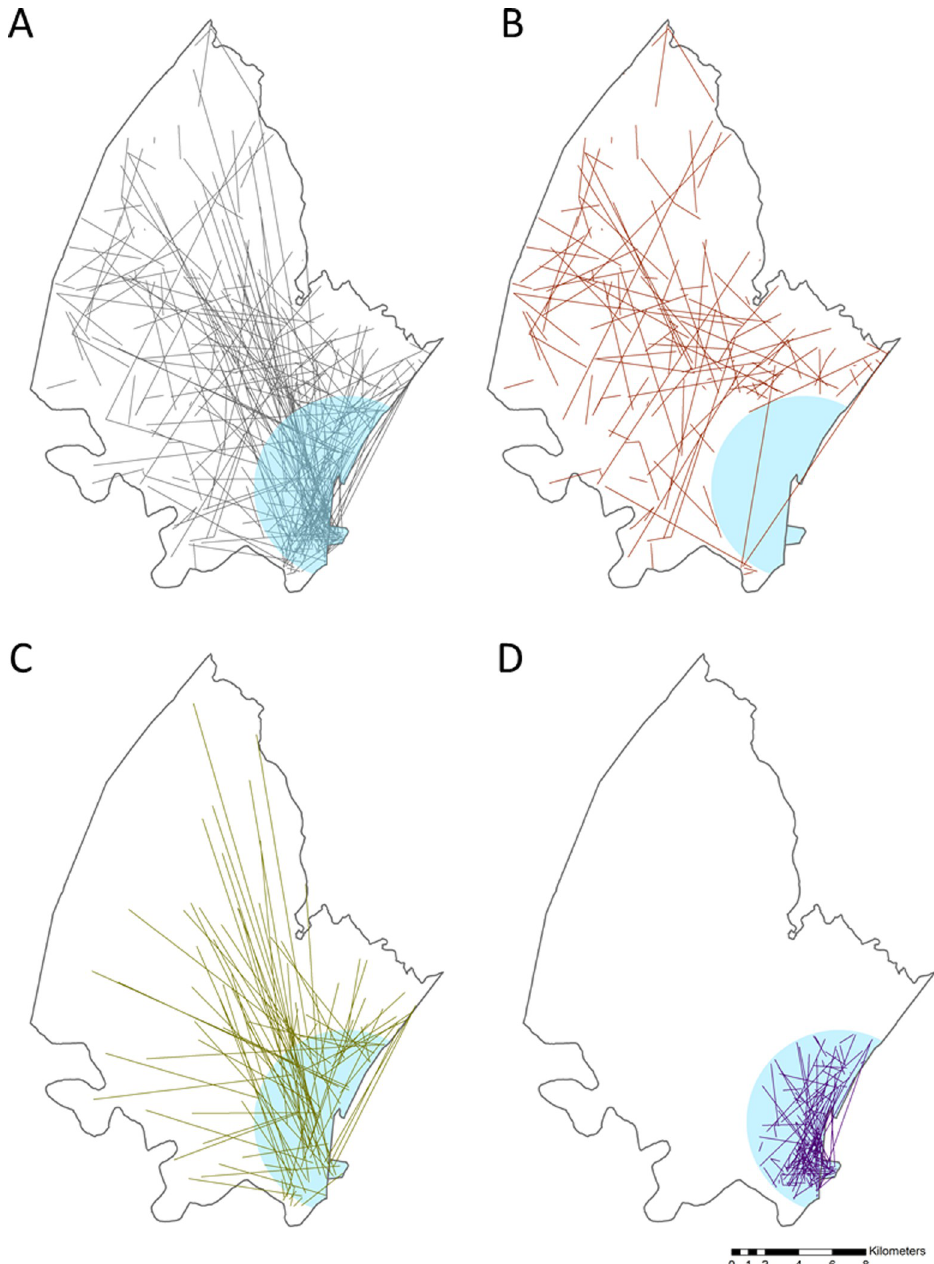
Fig 1. Linkage of female and male partners of stable sexual relationship pairs in which both partners were residents at the start of sexual partnership formation. A) All links formed by partners in which both where located within the surveillance area at the beginning of the relationship (n = 495); B) formation links where both partners were located outside the peri-urban HIV cluster area (n = 117); C) formation links where only one partner is located within the peri-urban HIV cluster area (n = 148); D) formation links where both partners were located inside the peri-urban cluster area (n = 230). The location of the peri-urban HIV cluster area is represented by the blue area. Only approximate locations are shown in the map to protect confidentiality of